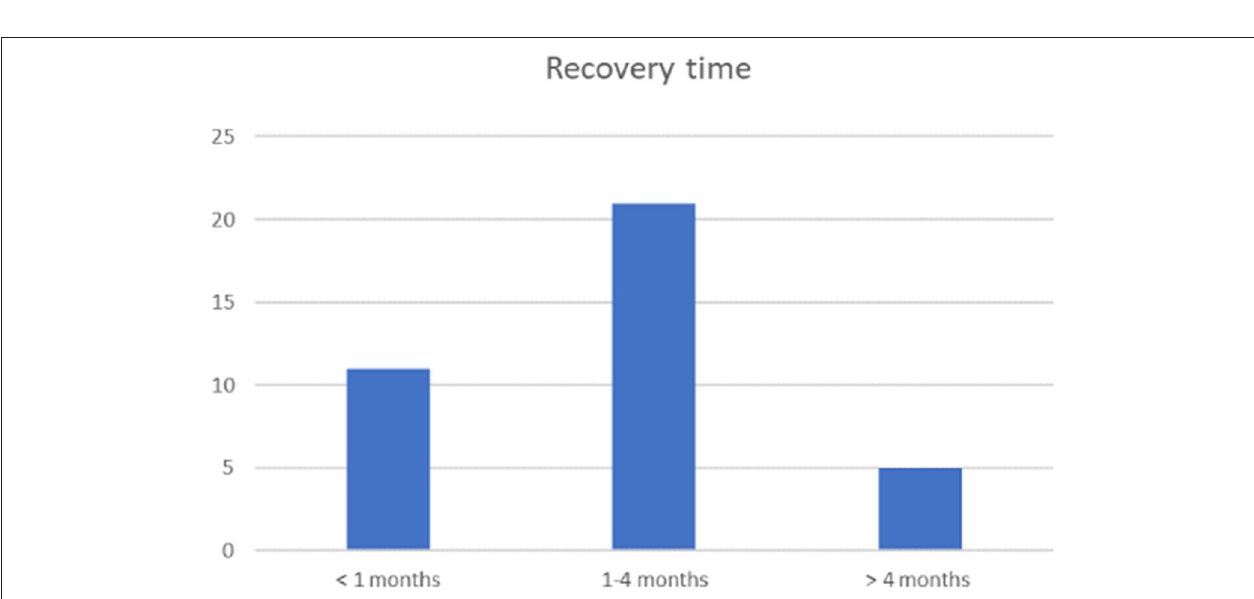
FIGURE 6 | Recovery time. Representation of recovery time in the three groups (weeks: 1–4 months, months: 1–4 months and late: > 4 months), with total amount of patients indicated on the y axis.